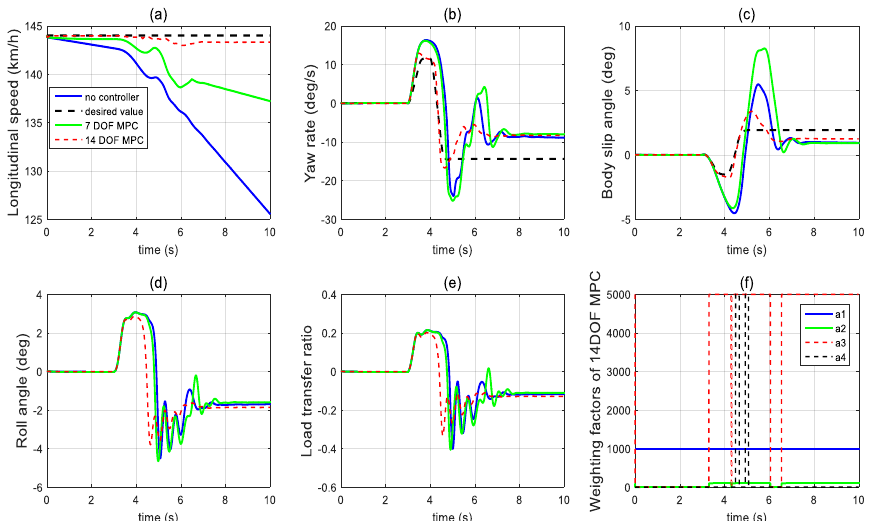
Figure 19. Vehicle dynamics performance when proposed controller applied in the third set of simulations ( a ) longitudinal velocity, ( b ) yaw rate, ( c ) body side-slip angle, ( d ) roll angle, ( e ) LTR, ( f ) scaling factors of 14 DOF MPC.